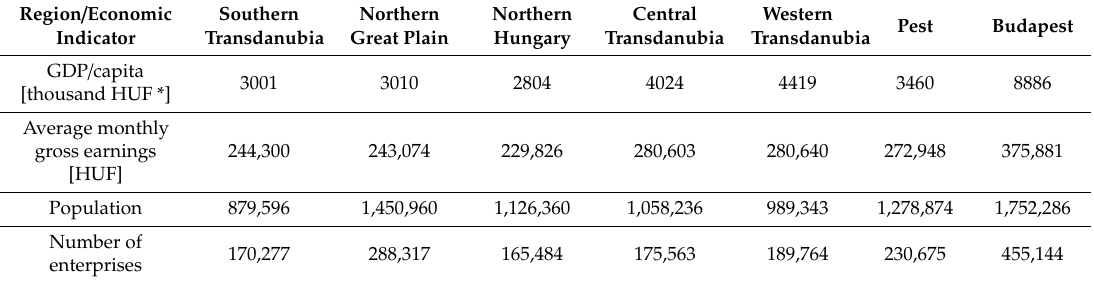
Table 1. Indicators of the seven examined regions of Hungary based on [52]. (* Hungarian forint, HUF). Region / Economic